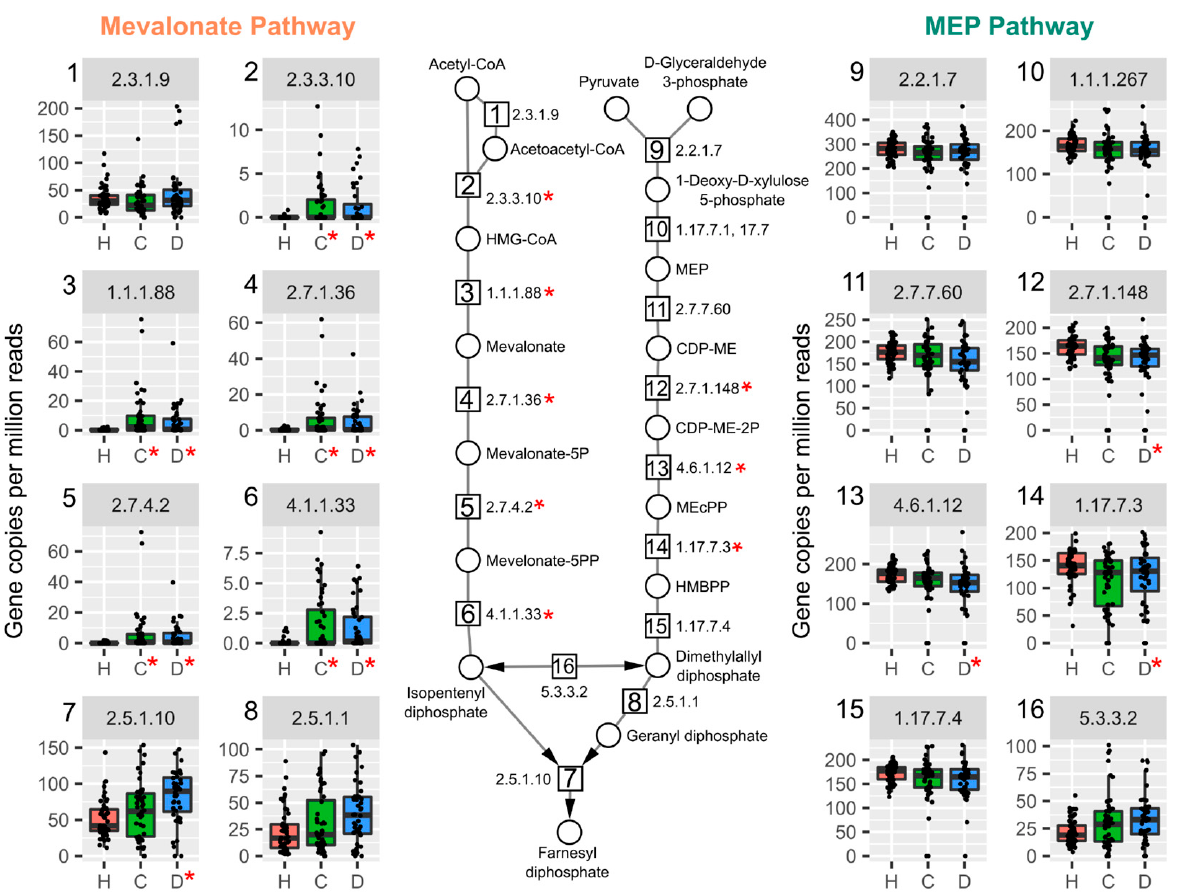
Figure 4. Mevalonate-dependent isoprenoid biosynthesis genes are enriched in a published metagenomics dataset of fecal samples from cirrhosis patients. Humann3 analysis of fecal gut microbiomes in healthy (H, red, n = 52), compensated (C, green, n = 48), or decompensated (D, blue, n = 44) cirrhosis for mevalonate-dependent and methyl-D-erythritol 4-phosphate (MEP) pathways. Individual boxplots are numbered with the EC number matching the enzymatic step in pathway schematic. Significance is denoted with a red asterisk (*, adjusted p -values < 0.05) compared to healthy group. Abbreviations.: 3- hydroxyl-3-methyl-clutaryl-CoA (HMG-CoA), (R)-5-Phosphomevalonate (mevalonate-5P), (R)-5-Diphosphomevalonate (mevalonate-5PP), 2-C-Methyl-D-erythritol 4-phosphate (MEP), 4-(Cytidine 5 (cid:48) -diphospho)-2-C-methyl-D-erythritol (CDP- ME), 4-(Cytidine 5 (cid:48) -diphospho)-2-C-methyl-D-erythritol (DEP-ME-2P), 2-C-Methyl-D-erythritol 2,4-cyclodiphosphate (MEcPP), 1-Hydroxy-2-methyl-2-butenyl 4-diphosphate